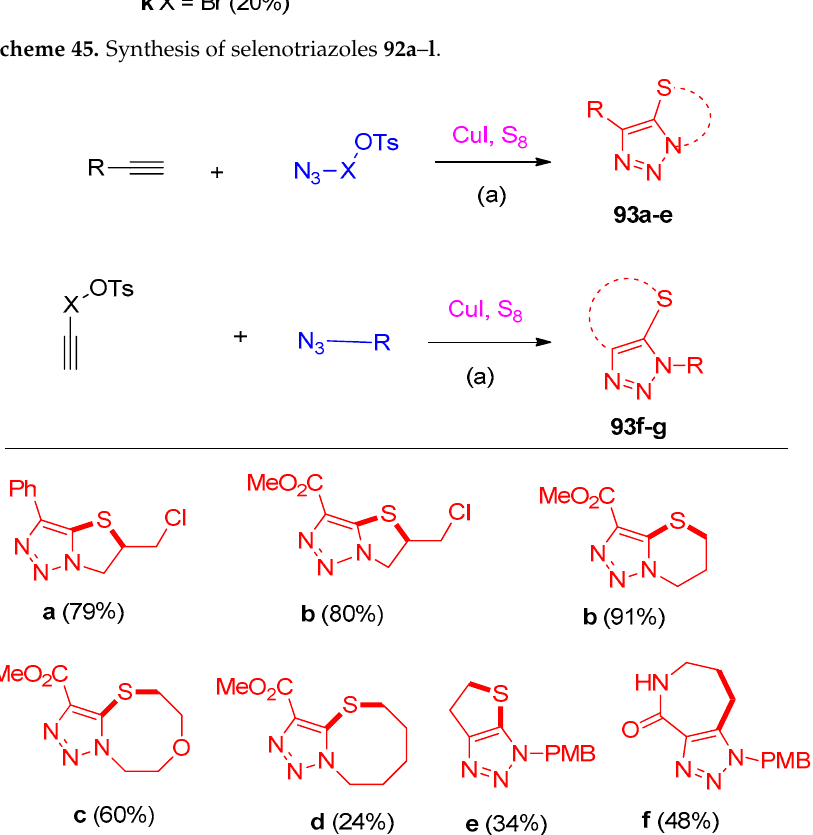
Scheme 46. Synthesis of fused bicyclic 5-thiotriazoles. Reagents and conditions : (a) CuI (0.65 mmol),